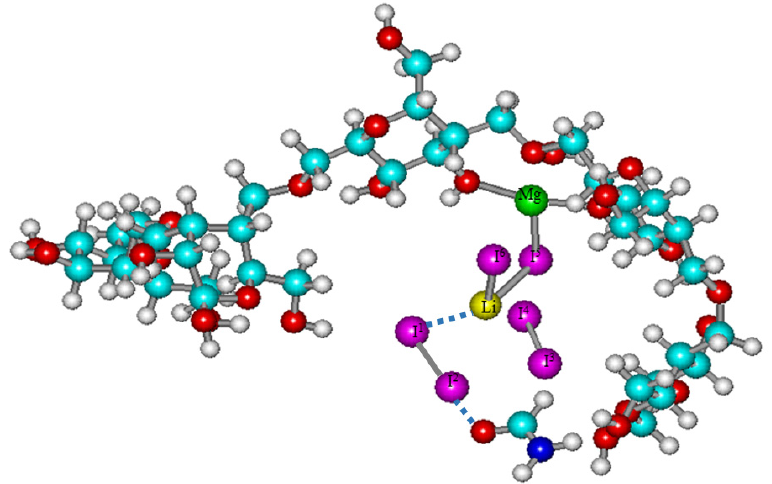
Figure 3. Complex II. A binuclear complex of magnesium and lithium, including molecular iodine and triiodide (MgI 3 LiII 2 ) in the dextrin ring. Blue balls—carbon atoms, red balls—oxygen, dark balls—nitrogen, violet balls—iodine, green balls—magnesium ion, yellow balls—lithium ion, white balls—hydrogen atoms.